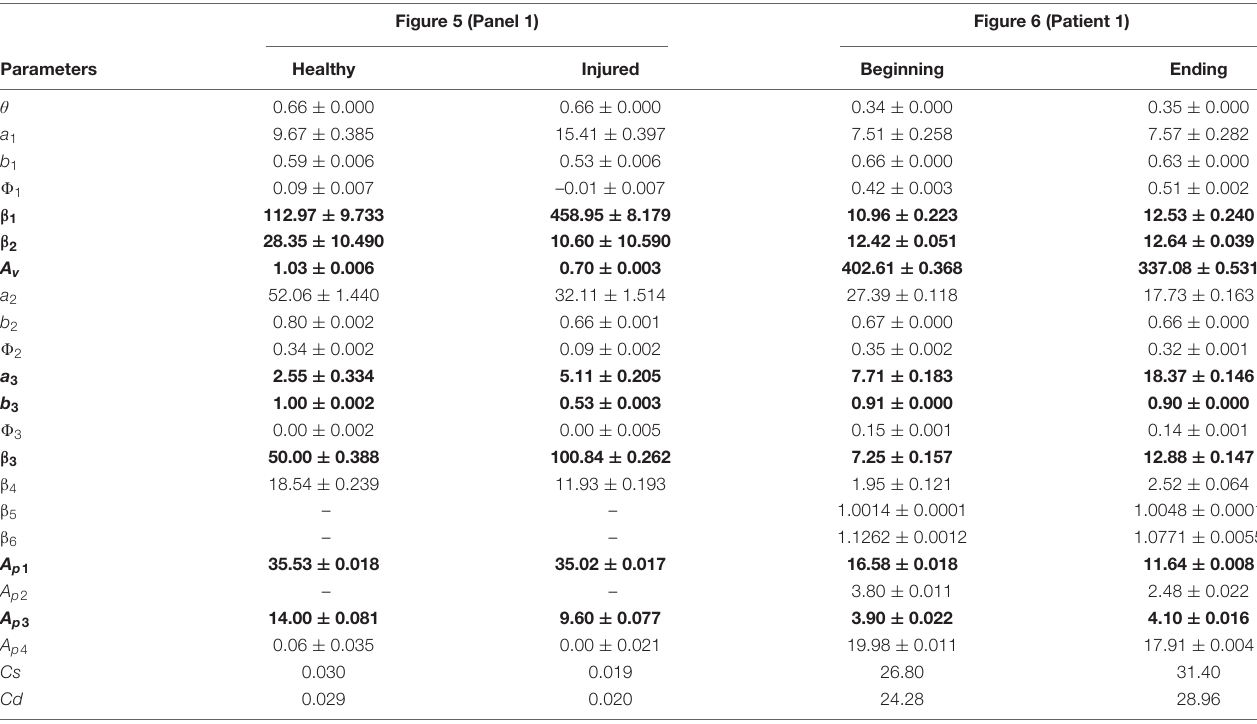
TABLE 2 | Estimated model parameters obtained from the optimization scheme for the results shown in Figure 5 (Panel 1) and Figure 6 (human patient 1) correspond to the mouse and human data, respectively. Figure 5 (Panel 1) Figure 6 (Patient